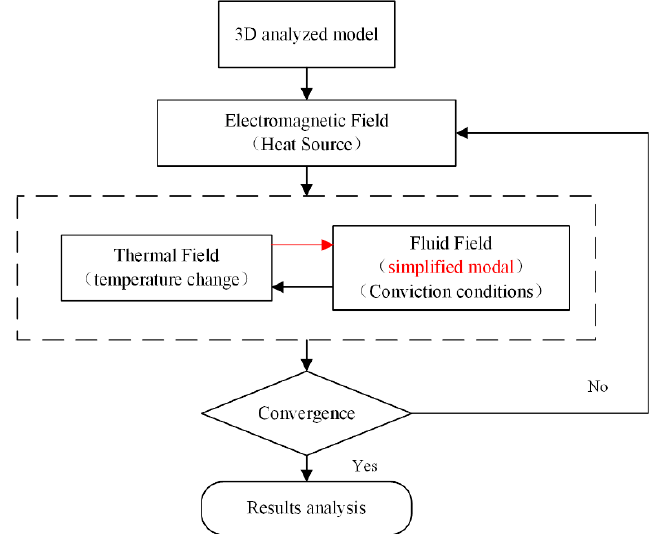
Figure 11. Analysis flow chart of the three-dimensional (3D) electromagnetic-fluid-thermal (EM-FT) coupled field. Reprinted with permission from ref. [75]. Copyright 2015 Elsevier Ltd.